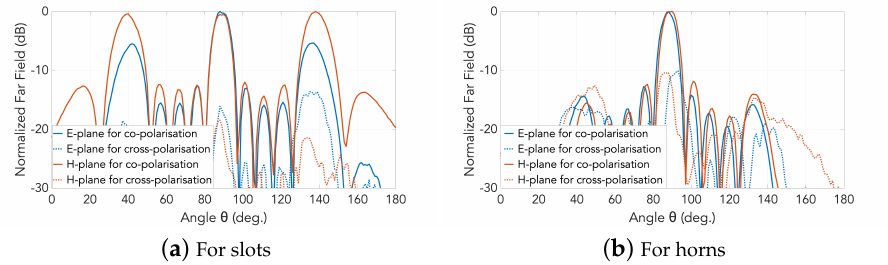
Figure 17. Normalized measured far-field patterns (solid traces, co-polar; dotted traces, cross-polar):